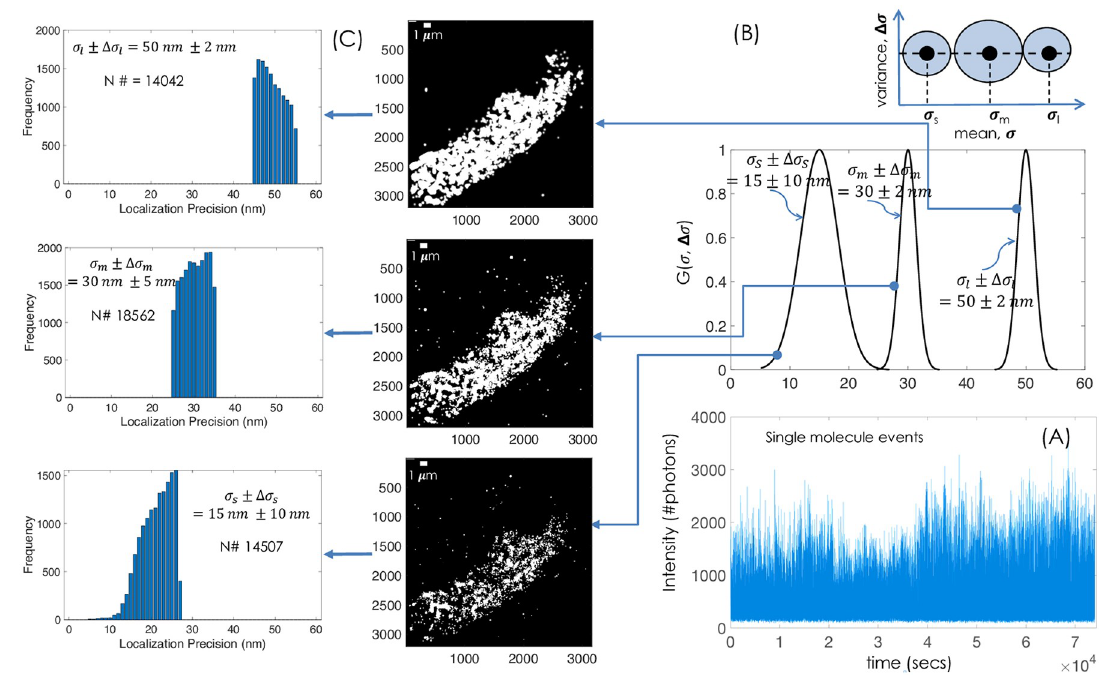
Fig 2. Multiresolution ultra-superresolution imaging using POSSIBLE microscopy. (A) The histogram of single molecule images as recorded by the EMCCD detector (Andor 897 iXon Ultra). (B) Three different Gaussian filters ( G ( σ reconstructing 3 distinct POSSIBLE images. Schematic of ( σ , Δ σ ) space is also shown, (C) Reconstructed images with the corresponding localization precision histogram for highly-resolved molecules (corresponding to G ( σ s , Δ σ s )), moderately-resolved molecules ( G ( σ m , Δ σ m )) and poorly-resolved molecules ( G ( σ l , Δ σ l )), respectively. Scale bar is 1 μm